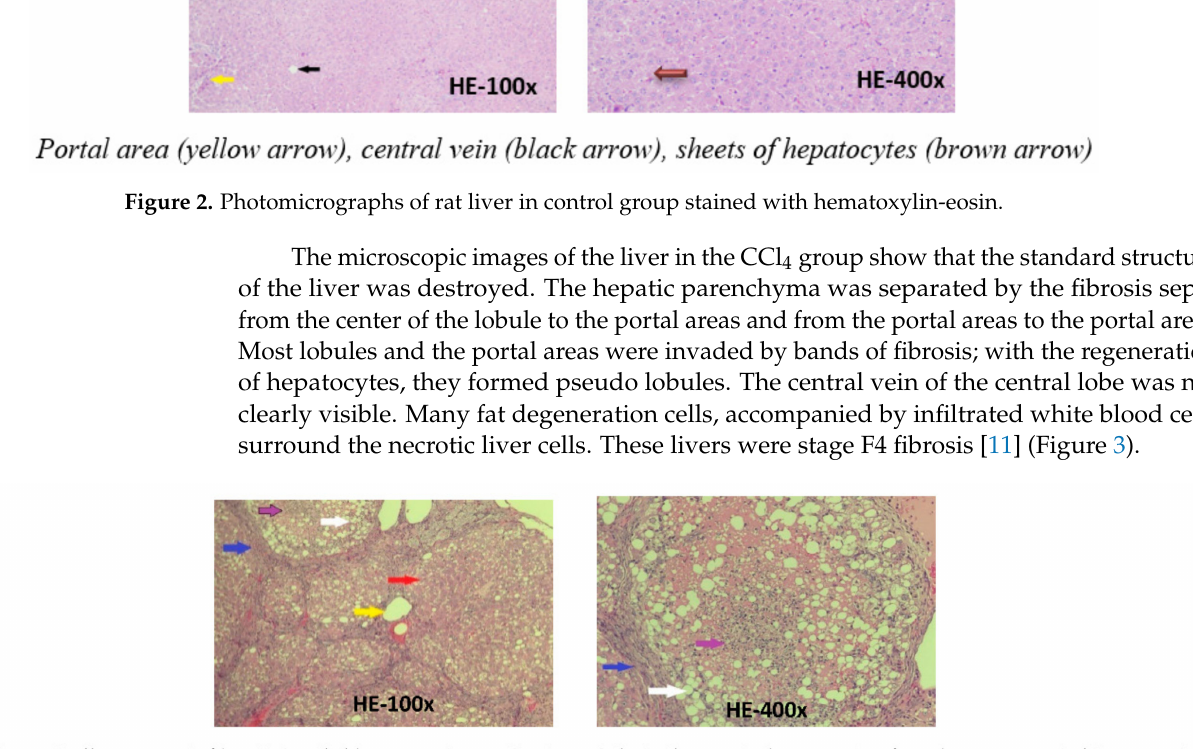
Figure 3. Photomicrographs of rat liver in CCl 4 group stained with hematoxylin-eosin. The microscopic images of livers in the silymarin group and HHM group and HHE- 1/1 group: the structure was maintained, hepatic parenchyma did not appear in pseudo lobules. However, the appearance of short fibrous bands, extending the portal areas, dissecting the liver parenchyma can be observed. The liver parenchyma of the HHM